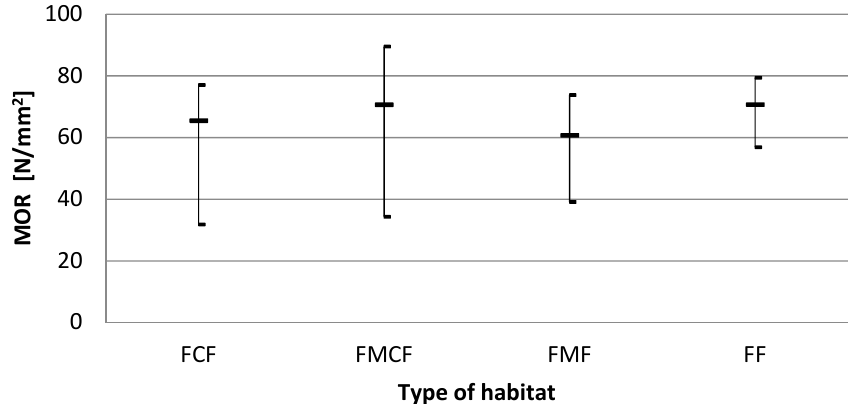
Figure 3. The average flexural strength of wood from different forest habitats (Source: Author’s original compilation).